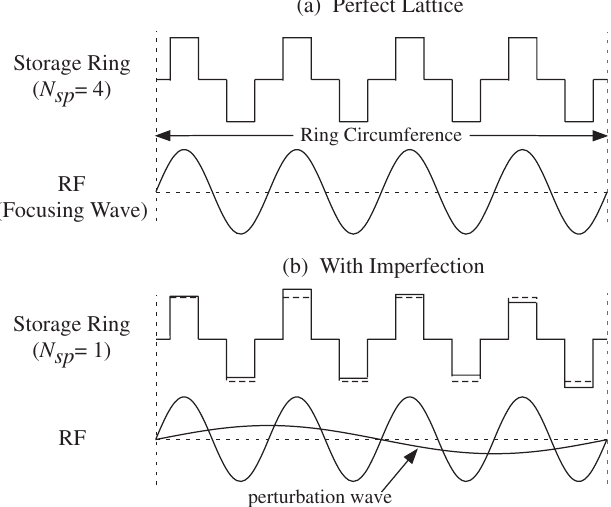
FIG. 3. Example of a ring lattice emulation scheme in the S- POD experiments. A single FODO period corresponds to a single sinusoidal rf period. Error fields reduce the strict lattice periodicity to unity, which can be approximately modeled by superimposing a perturbation wave (shown in exaggerated scale).